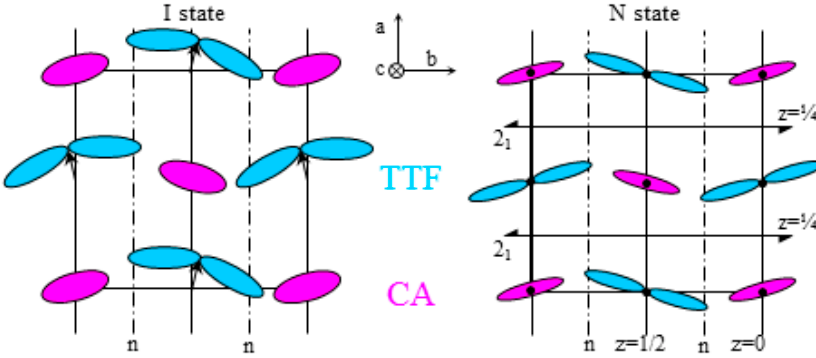
Figure 3. Schematic drawing of the structural changes in TTF-CA from the N ( P2 1 /n) to I ( Pn ) phase including symmetry breaking and isostructural ones.